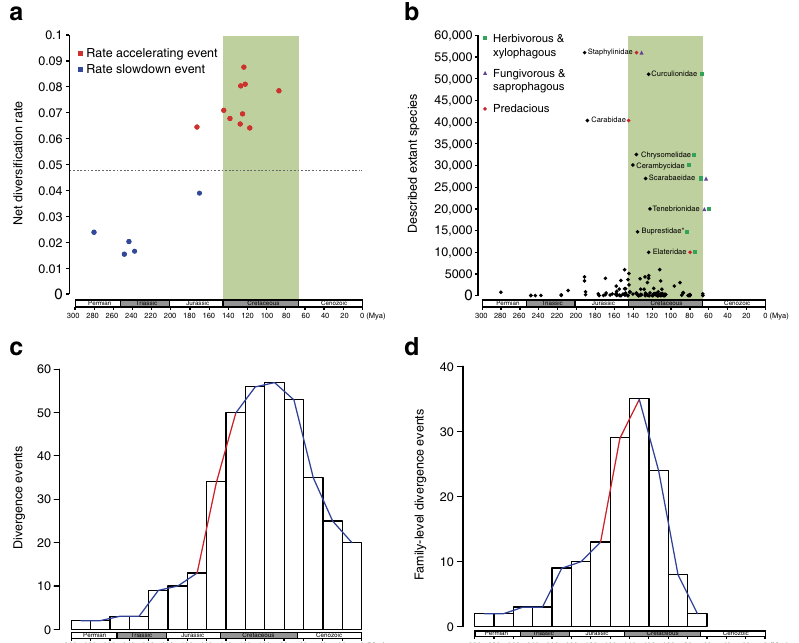
Fig. 5 Diversi fi cation of beetles across the geological timescale. a Timing of the 15 signi fi cant changes in net diversi fi cation rate identi fi ed by MEDUSA. The dashed line denotes the background net diversi fi cation rate of Coleoptera. b Origin times and the species richness of beetle families. We used stem age as the origin time for a family when only one species is sampled for the family or when the taxon sampling did not cover the crown of the family. For non- monophyletic families, the stem age of the oldest lineage of the family was used. The nine largest families with species numbers > 10,000 are highlighted with family names and feeding habits. For the Buprestidae (marked with an asterisk), we performed an additional time estimation, adding the Schizopodidae sequences from McKenna et al. 16 to calculate the stem age of this family. c Number of divergence events within every 20 million year interval calculated from the 383-taxon time tree. Note that the diversi fi cation rate of beetles experienced an upsurge beginning from the late Jurassic (marked with a red line). d Number of divergence events within every 20 million year interval calculated from the family-level time tree. A similar diversi fi cation upsurge pattern was also detected in the late